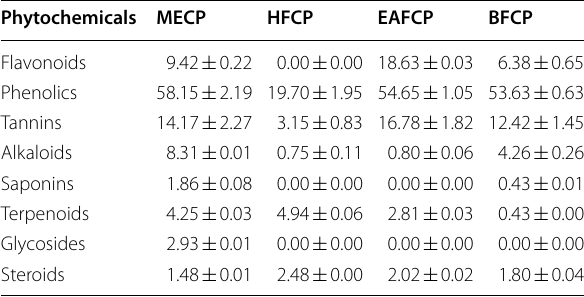
Table 2 Qualitative screening of C. paniculatum extracts and fractions